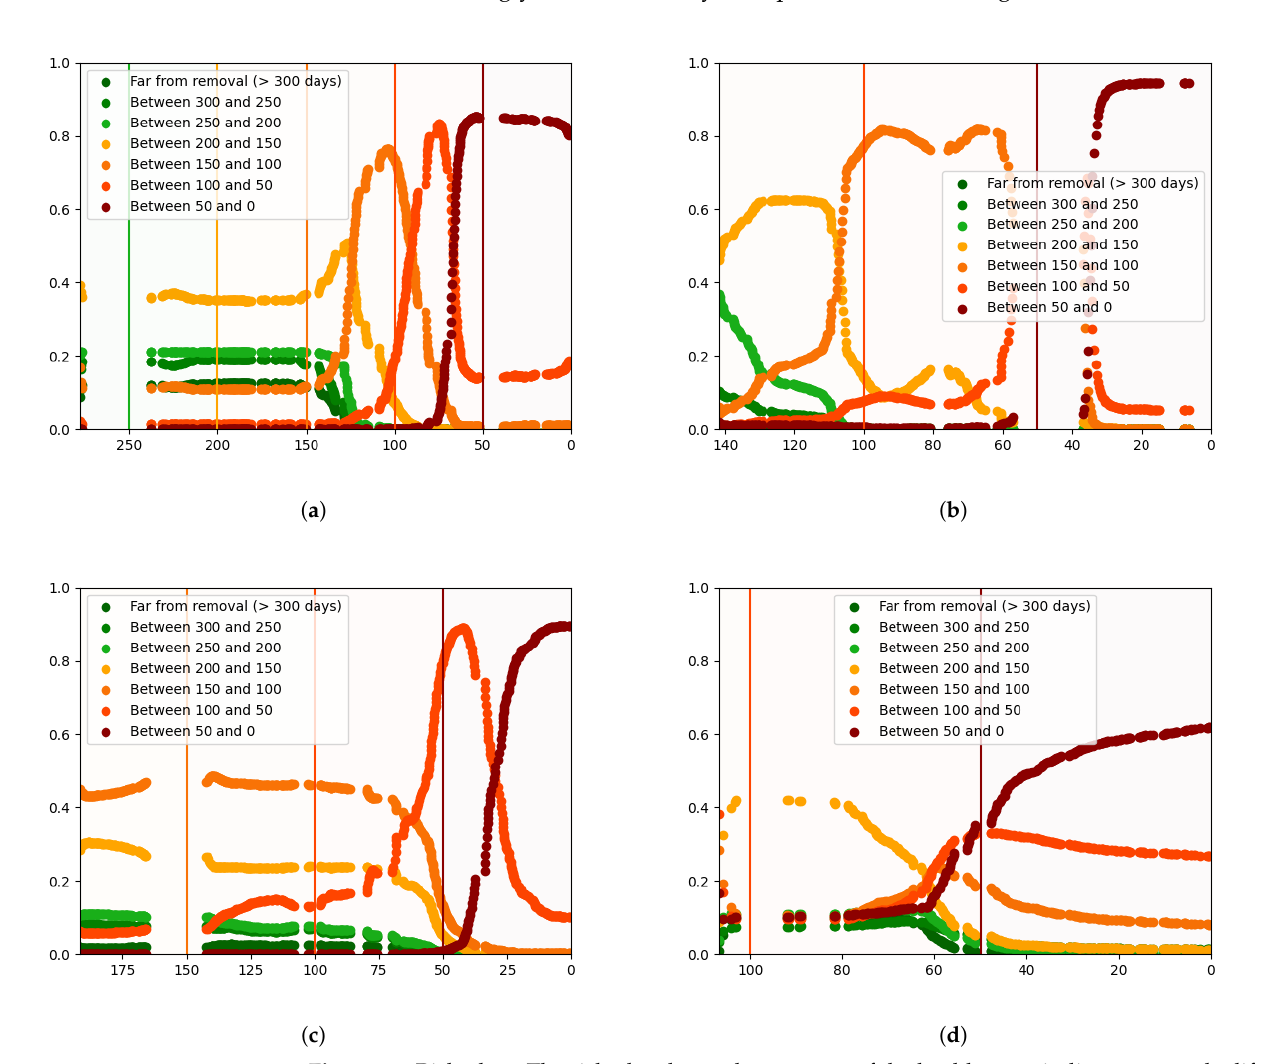
Figure 16. Risk plots. The risk plot shows the progress of the health stage indicators over the life of four equipment units. Each of these plots shows the predictions of the GRU model over the life of an equipment. ( a ) Random Equipment #1; ( b ) Random Equipment #2; ( c ) Random Equipment #3; ( d ) Random Equipment